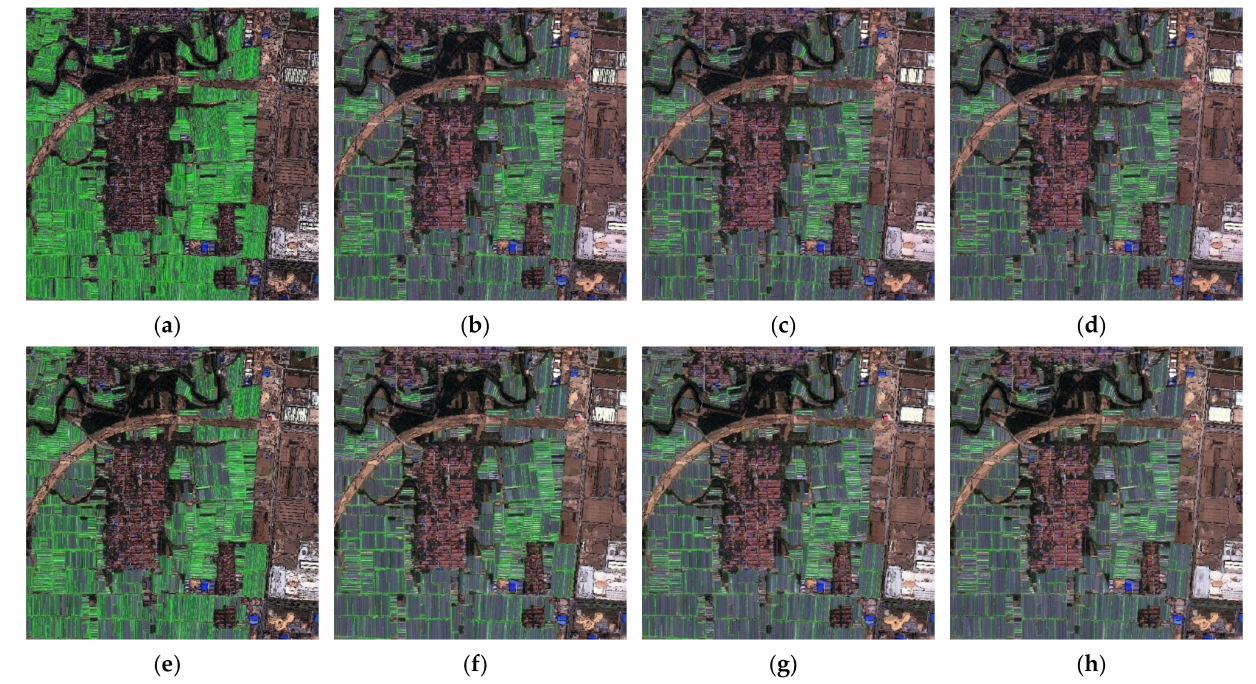
Figure 7. Effects of linear compression and mean filtering on EPGSs of ACFI: ( a ) MDN initial;